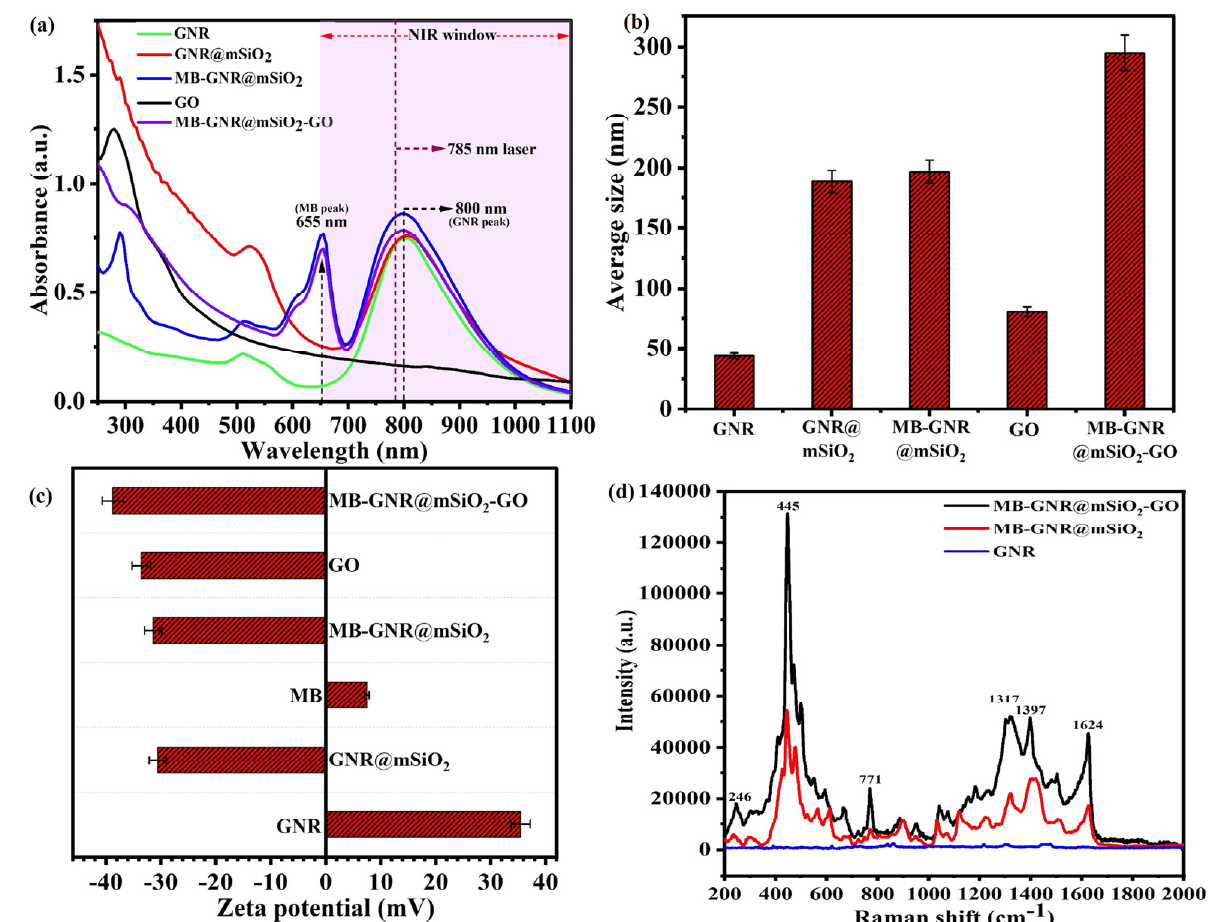
Figure 3. ( a ) UV–vis spectra of gold nanorods (GNRs), mesoporous silica-coated gold nanorods (GNR@mSiO 2 ), methylene blue-loaded mesoporous silica-coated gold nanorods (MB-GNR@mSiO 2 ), graphene oxide (GO), and methylene blue-loaded mesoporous silica-coated gold nanorods on gra- phene oxide (MB-GNR@mSiO 2 -GO). ( b ) Particle size distribution histograms of GNR, GNR@mSiO 2 ,